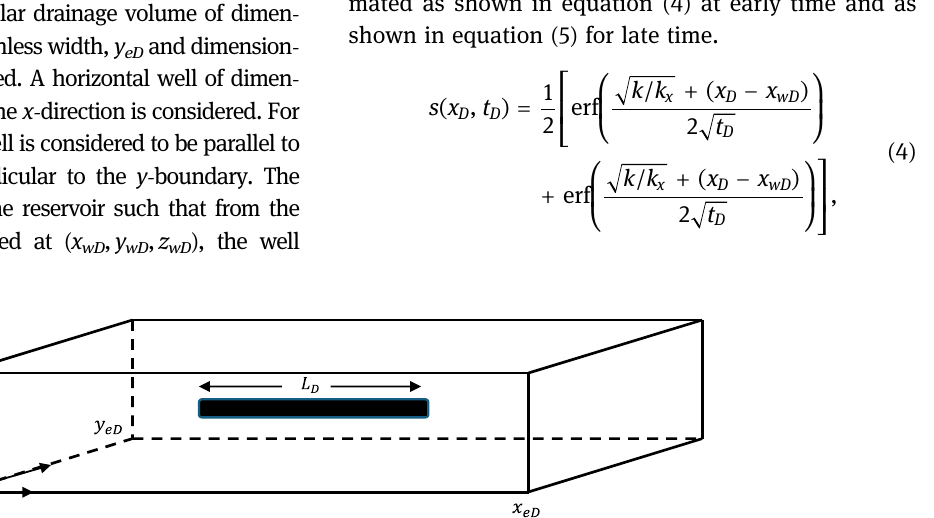
Figure 1: Horizontal well in a rectangular drainage